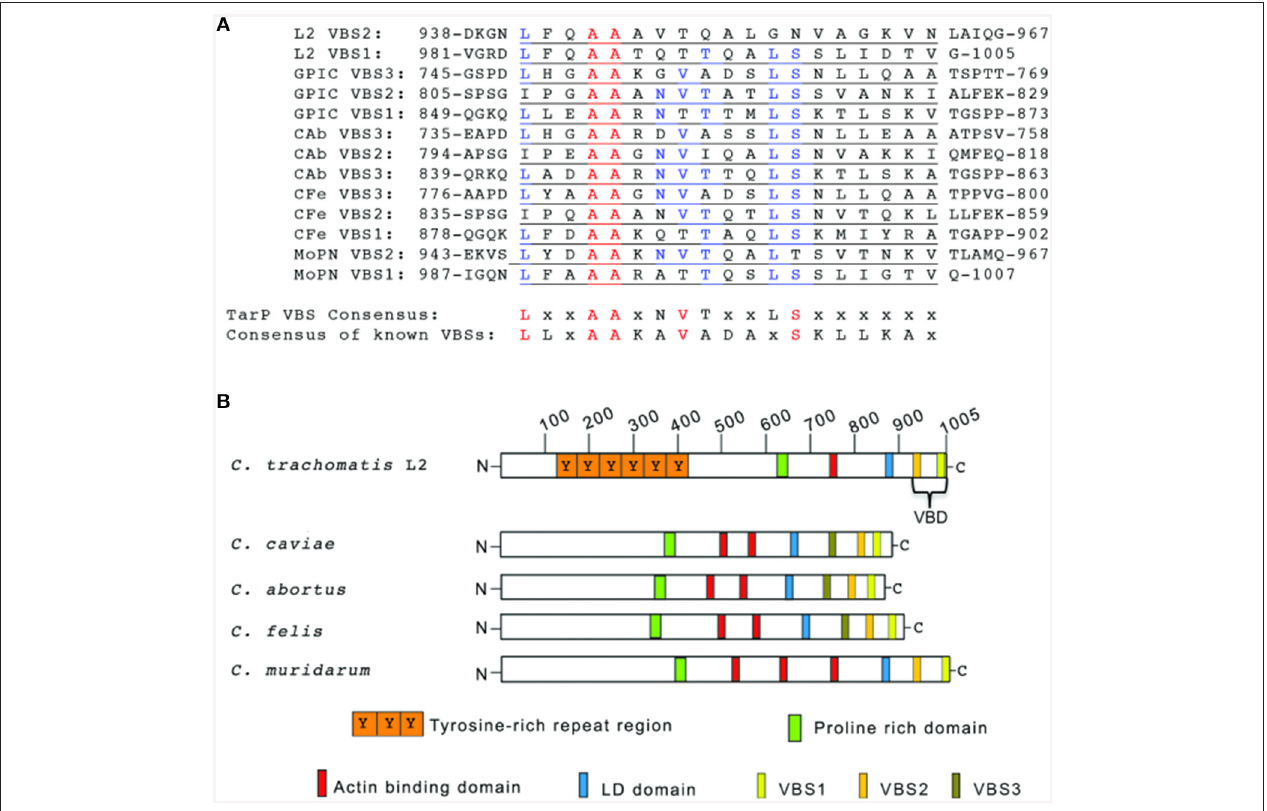
FIGURE 2 | TarP orthologs harbor multiple vinculin binding sites. (A) Schematic of TarP orthologs from C. trachomatis serovar L2 (L2), C. trachomatis serovar D (D), C. trachomatis serovar A (A), C. caviae (GPIC), C. abortus (Cab), C. felis (CFe), and C. muridarum (MoPN). Indicated are the locations of the tyrosine-rich phosphorylation domain (orange box), the proline rich domain (green box), actin binding domains (red box), and the LD domain (blue box). Vinculin Binding Site 3 (VBS3; brown box), VBS2 (light orange box), and C-terminal VBS1 (yellow box) together comprise the Vinculin Binding Domain (VBD). (B) ClustalW sequence alignment of the putative VBS motifs. The numbers indicate the amino acid residue of the amino terminus or carboxy terminus. The consensus sequences shown are based on homology greater than 50%. A 19-residue consensus motif (LLxAAKAVADAxSKLLKAx) was generated by aligning by aligning the 11VBSs of talin, the three VBSs of IpaA, and the two VBSs of sca4 for comparison to the TarP LD consensus (LxxAAxNVTxxLSxxxxxx). Identical amino acids are in red. Similar residues are in blue. “x” indicates any amino acid.